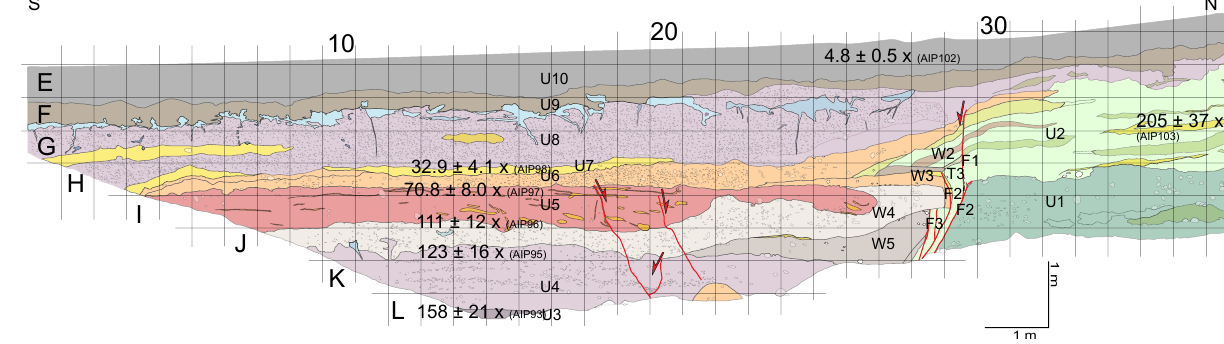
Figure 7. Trench log of the SW-facing wall of the trench SDF3 across the Markgrafneusiedl Fault (for location see Figs. 3a and 4). Colluvial wedges and underlying tension cracks related to earthquakes B2–B5 are numbered. The displacement related to B1 is marked. Numbers indicate the age and the location of IRSL samples. See text for further explanation. See Supplement for high-resolution